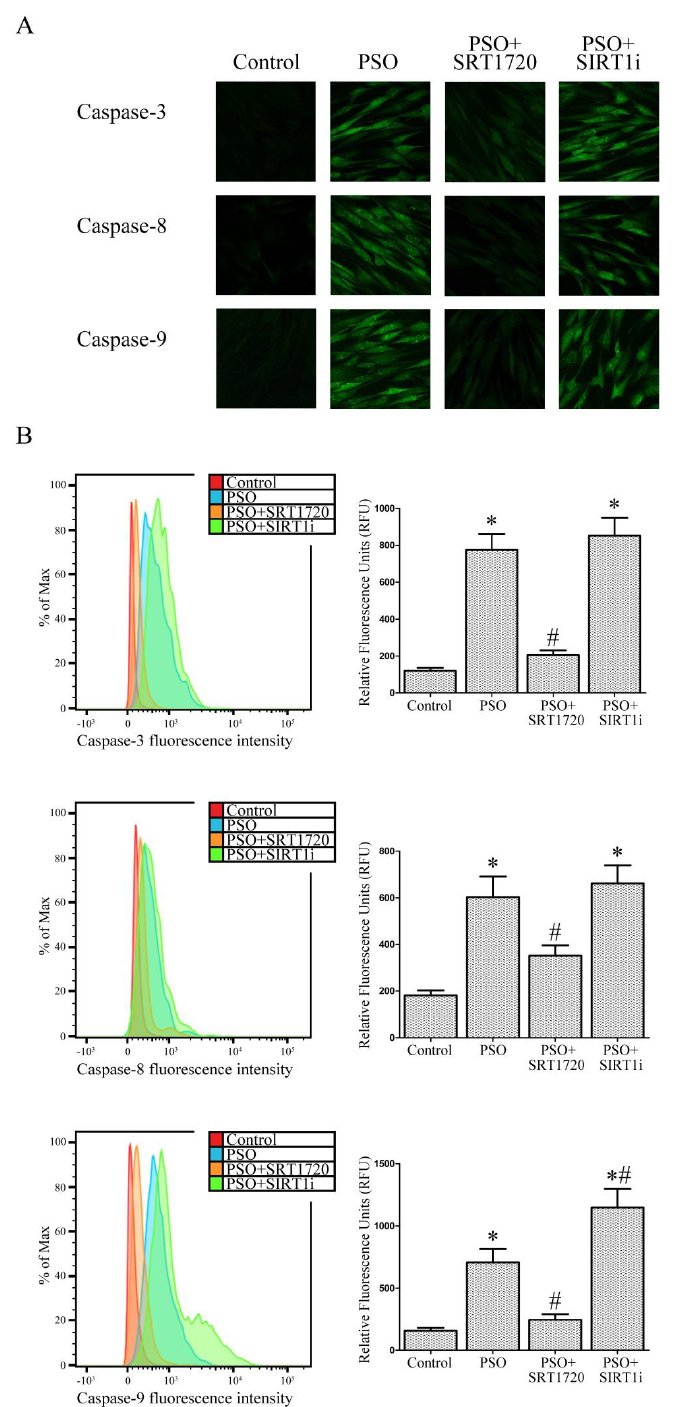
Figure 5. ( A ) Confocal microscope analysis (63 × magnification) and ( B ) flow cytometry analysis